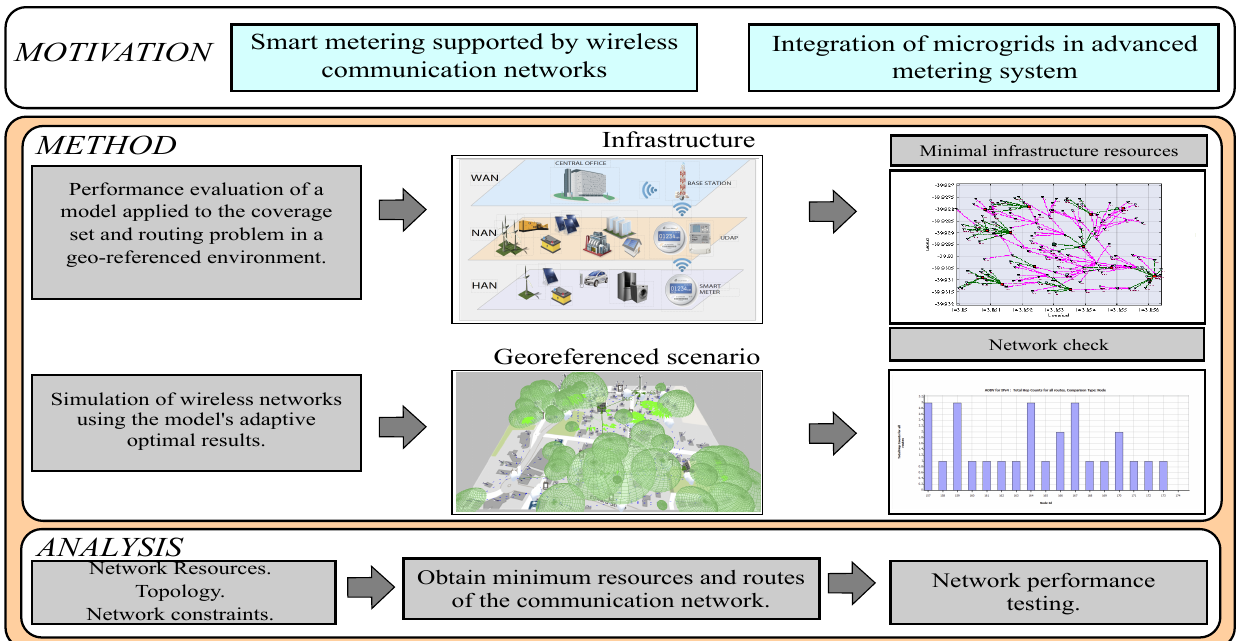
Figure 1. Conceptual graph of the optimal performance of a wireless network